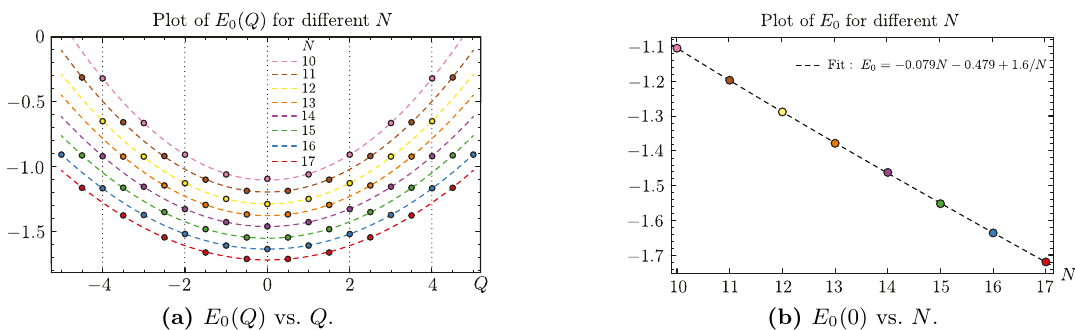
Figure 3. (a) The ground energy E 0 ( Q ) as a function of charge Q in units J ( q = 4). The number of samples for each charge are 250000 ( N = 10), 120000 ( N = 11), 50000 ( N = 12), 10000 ( N = 13), 2000 ( N = 14), 1000 ( N = 15), 500 ( N = 16), 200 ( N = 17). Dashed lines are (cid:12)t by E 0 ( Q ) = E 0 + aQ 2 . (b) Plot for the ground energy E 0 at zero charge. The dashed line is a (cid:12)t by E 0 = (cid:0) 0 : 079 N (cid:0) 0 : 479 + 1 : 6 =N . The leading large N term to be compared with 2 (cid:15) 0 , where (cid:15) 0 (cid:25) (cid:0) 0 : 0406